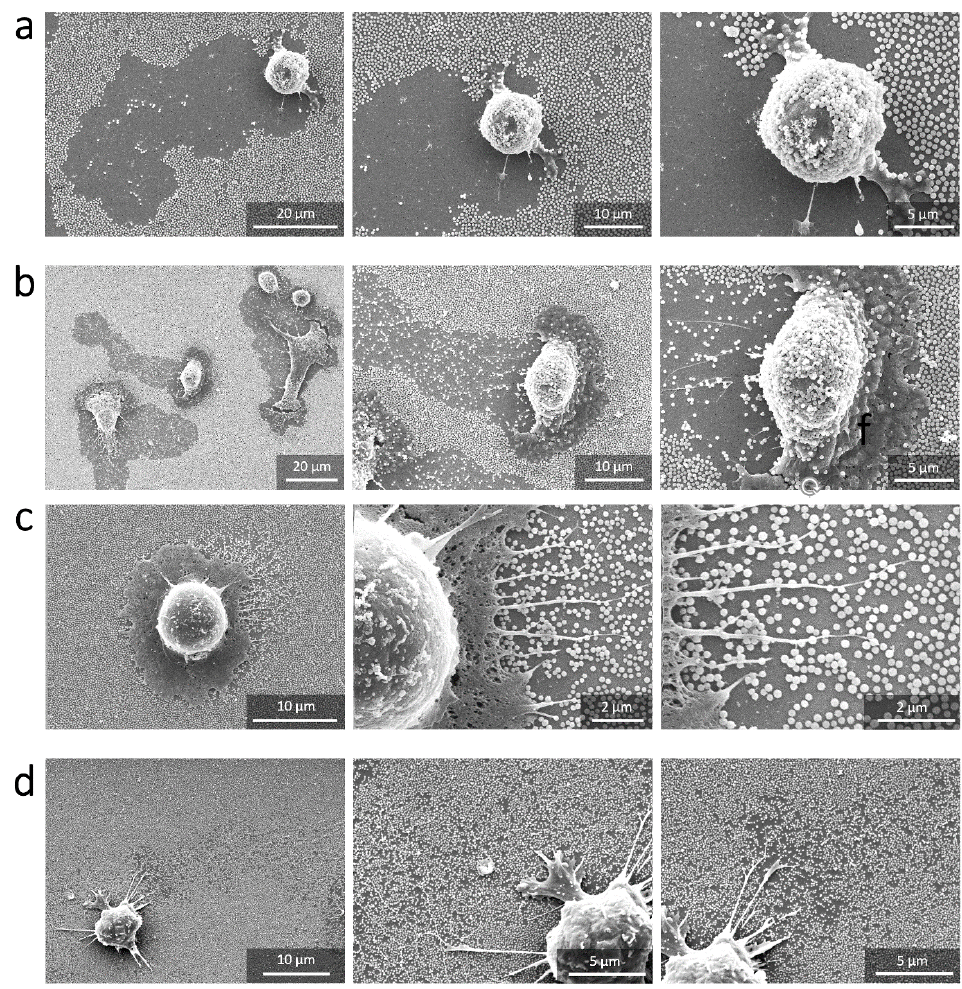
Figure 7. Series of SEM images (zoom in) of macrophages adhering on substrates decorated with silica NPs after 6 h of incubation. ( a ) 450 nm NPs. ( b ) 300 nm NPs. ( c ) 200 nm NPs. ( d ) 100 nm NPs.